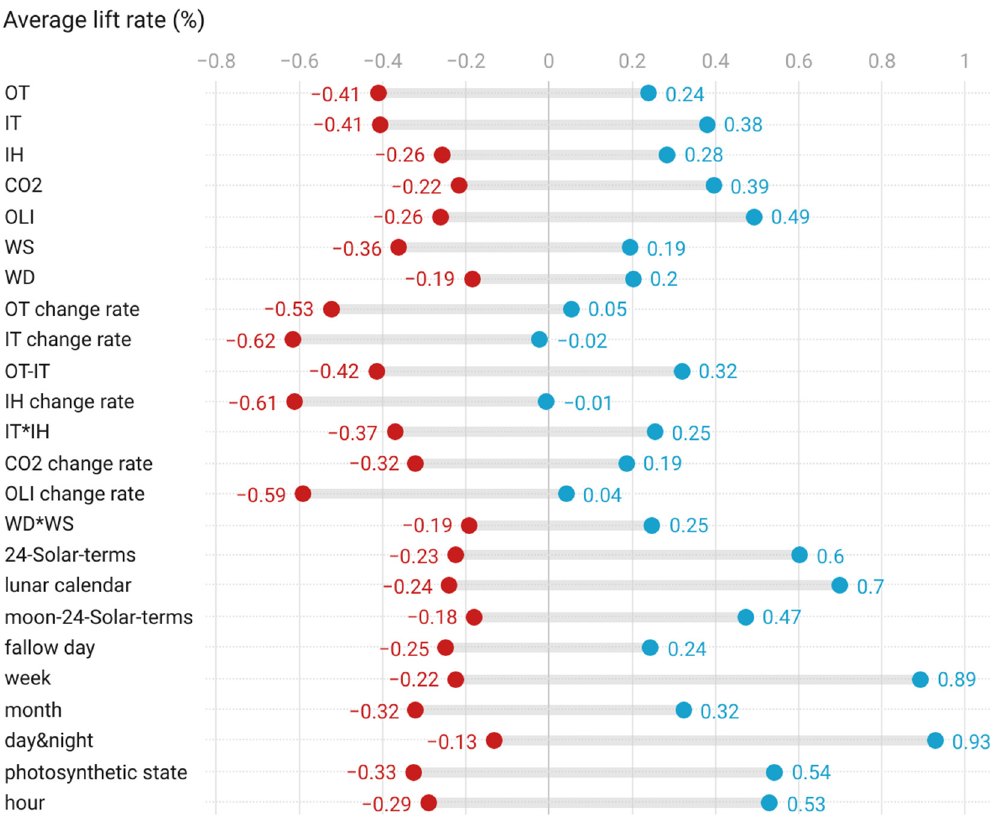
Figure 14. Average increase in the R 2 of the model (cross-combination encoding).